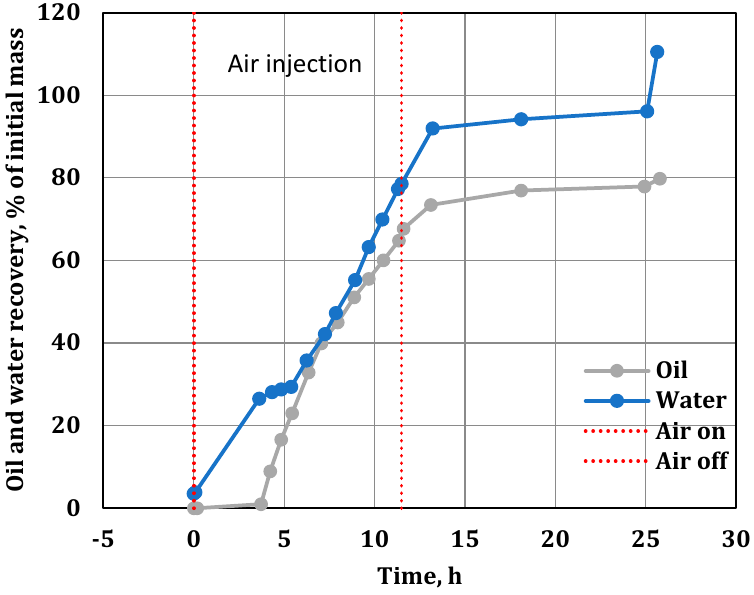
Figure 16. Oil and water recovery.